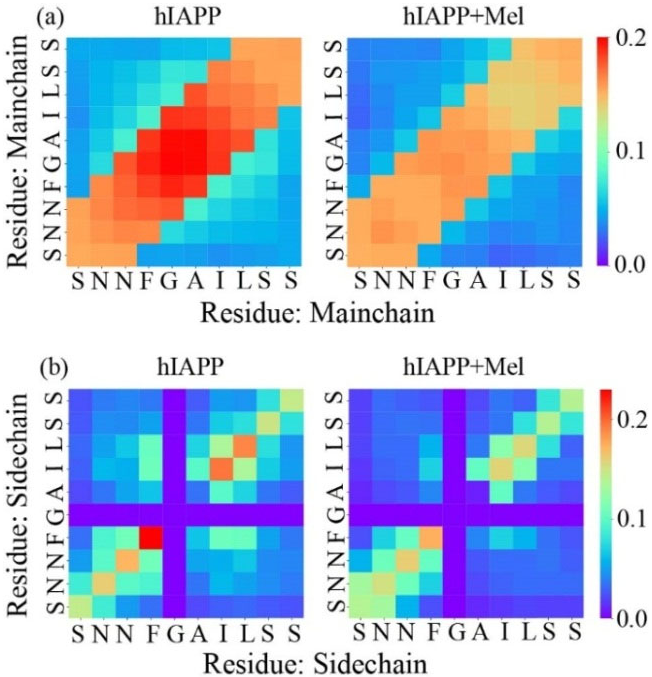
Figure 5. The interpeptide MC–MC ( a ) and SC–SC ( b ) contact probability maps for the hIAPP 20–29 octamer in the absence and presence of Mel.